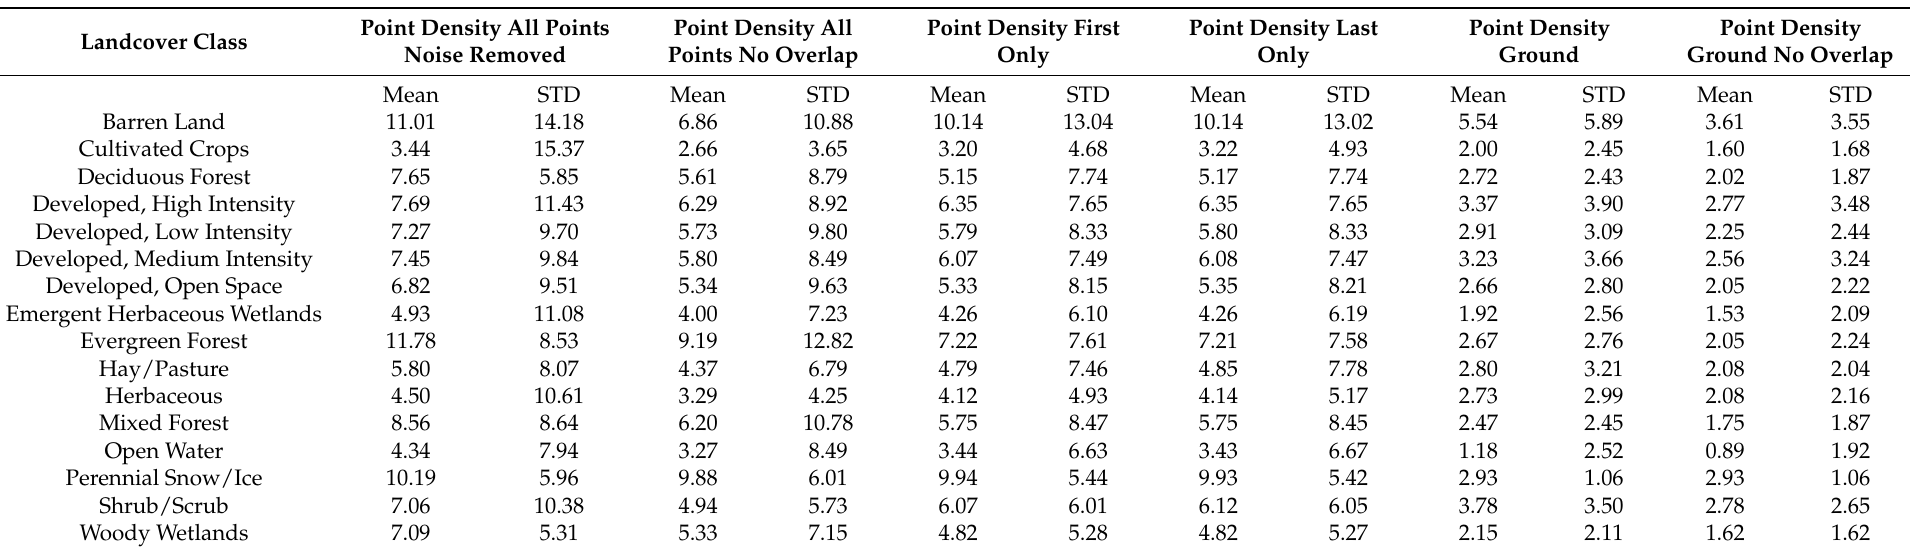
Table 13. Point density (pts/m 2 ) by USGS National Landcover Dataset land cover class (red = high density/variability, green = low density/variability) STD = Standard